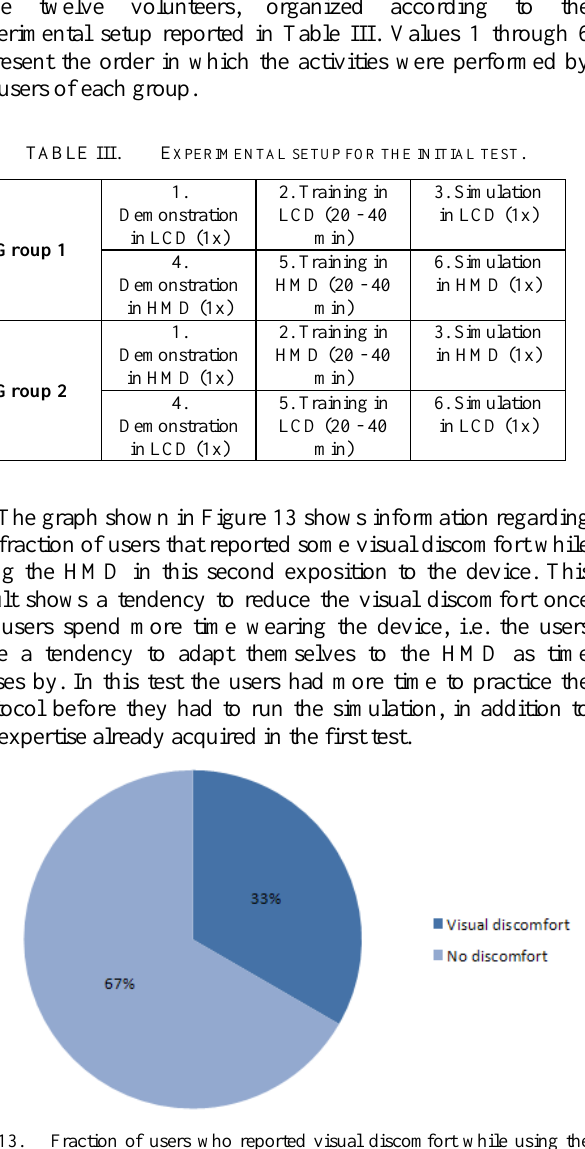
Fig. 13. Fraction of users who reported visual discomfort while using the HMD in the second